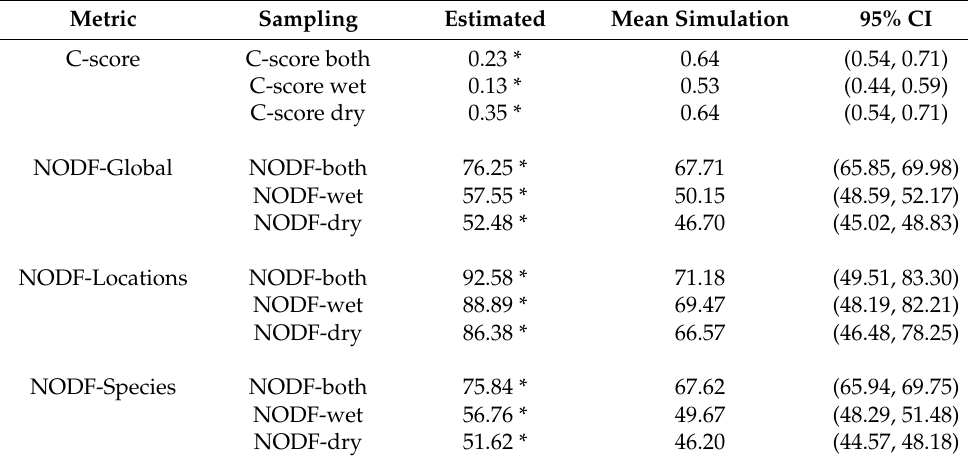
Table 2. C-score and nestedness overlap and decreasing fills (NODF) for sand fly species sampled at different land use plots and season in the Las Pavas and Trinidad de las Minas communities.